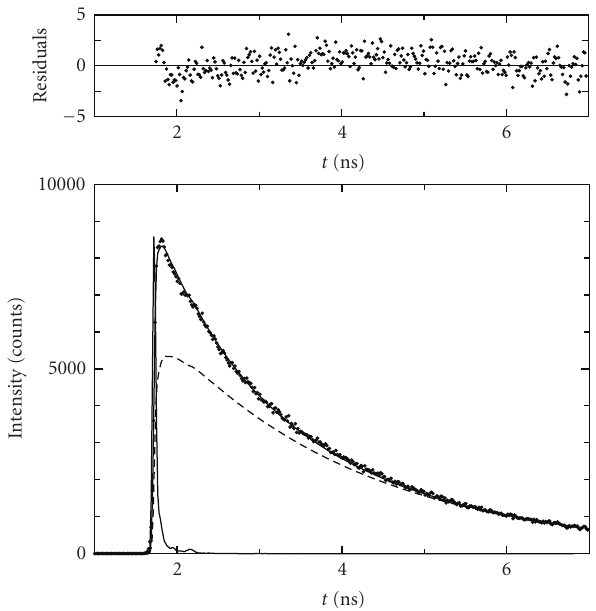
Figure 6: Observed decay curves (dots) of fluorescence of C522 quenched by TMPD (0.2M) in liquid para ffi n at 296 K, calculated best-fit to it (solid line), hypothetical decay curve (broken line), and residuals (upper dots). The thin solid line indicates the instrument response function. The ET parameters obtained are R 0 = 12 . 2 ˚ A and k 0 = 3 . 7 × 10 10 s − 1 , respectively, with χ 2 = 1 . 2786. See the text for the hypothetical decay curve.